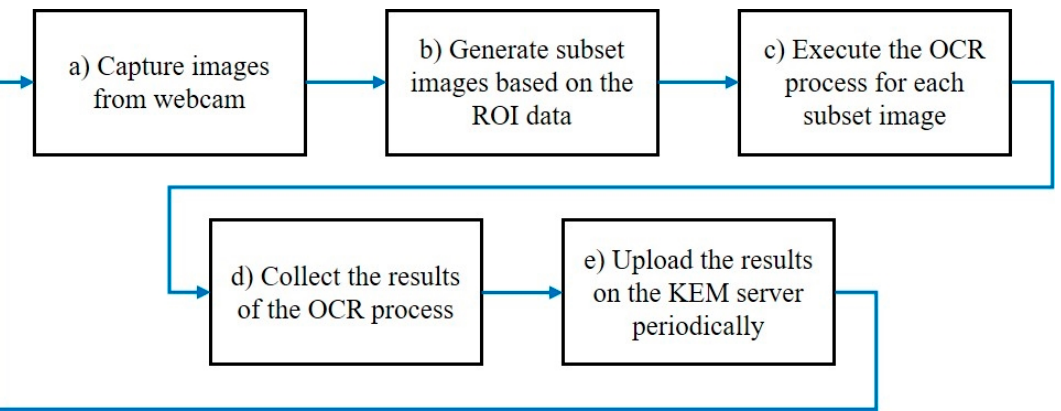
Figure 4. Configuration of the proposed KEM (keep an eye on your machine) monitoring system.